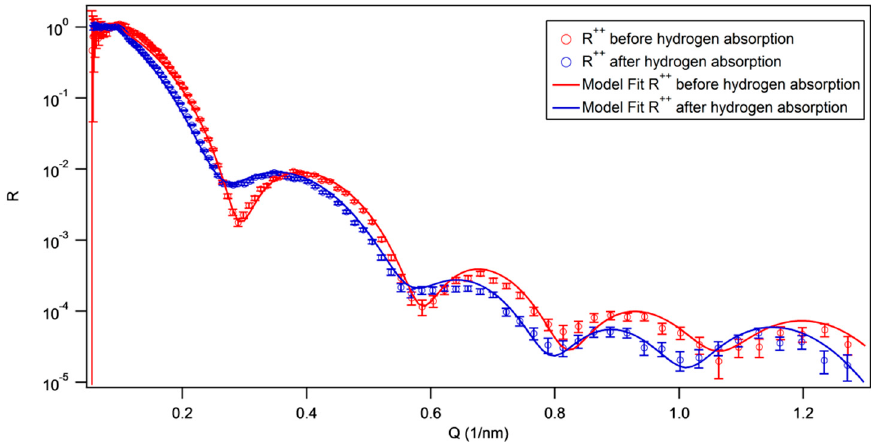
Figure 13. Comparison of R+ polarized neutron reflectivity data (circles) and fits (solid lines) for a Co/Pd bilayer before (red) and after (blue) exposure to 3.5% hydrogen gas partial pressure.